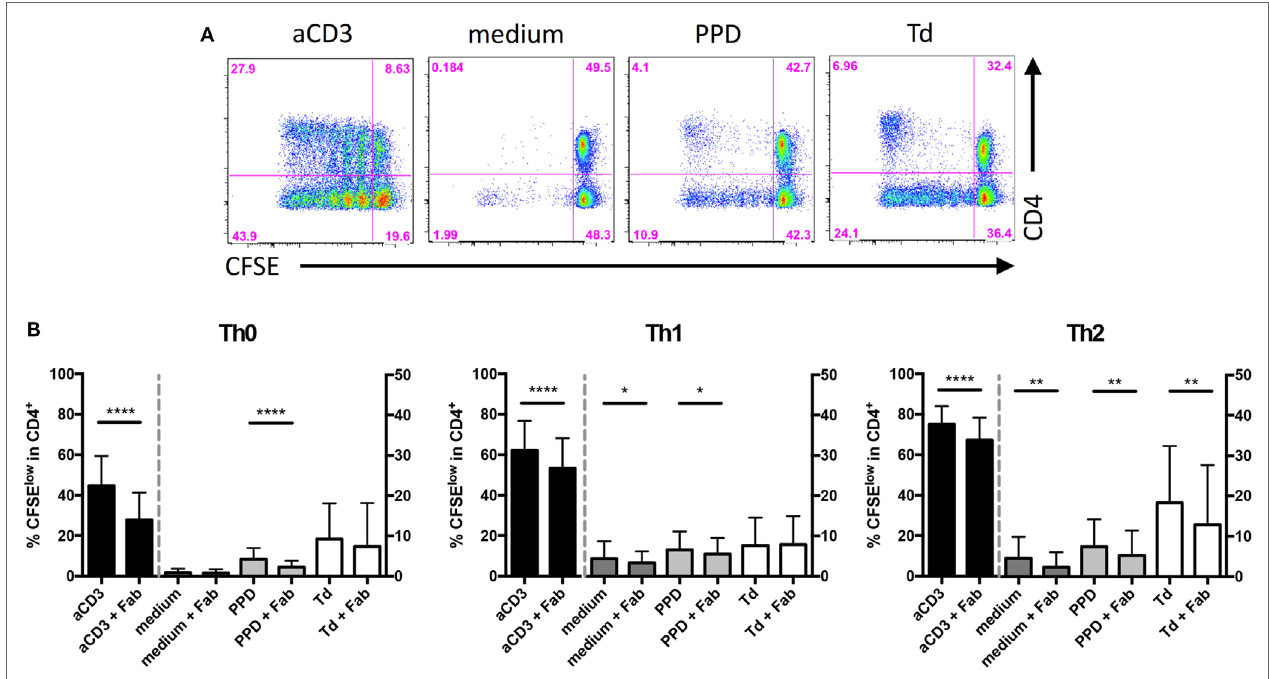
FigUre 4 | CD28 costimulation drives expansion of human purified protein derivative (PPD)-specific T helper 1 cells in vitro . Carboxyfluorescein succinimidyl ester diacetate (CFSE) (5 µM) labeled peripheral blood mononuclear cells were cultured in the presence or absence of anti-CD3 monoclonal antibody (mAb) (HIT3a), PPD, tetanus and diphtheria toxoid, and Fab fragments of anti-CD28 mAb CD28.3 under Th0, Th1, or Th2 conditions for 6 days. (a) Representative FACS data of CFSE dilution and CD4 expression. (B) Frequencies of proliferated cells among CD4 + cells cultured under Th0 (left), Th1 (middle), or Th2 (right) culture conditions. Graphs show mean + SD from 19 donors assayed individually and tested with a one-tailed paired t -test (* p < 0.05, ** p < 0.005, **** p <